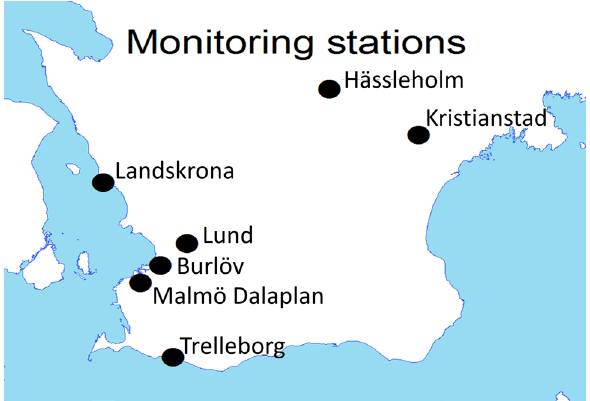
Fig. 4 Locations of measurement monitors